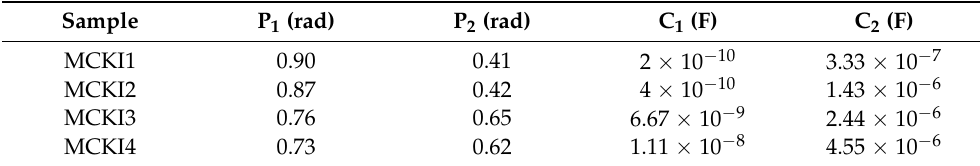
Table 1. The EEC fitting parameters for the systems fabricated.